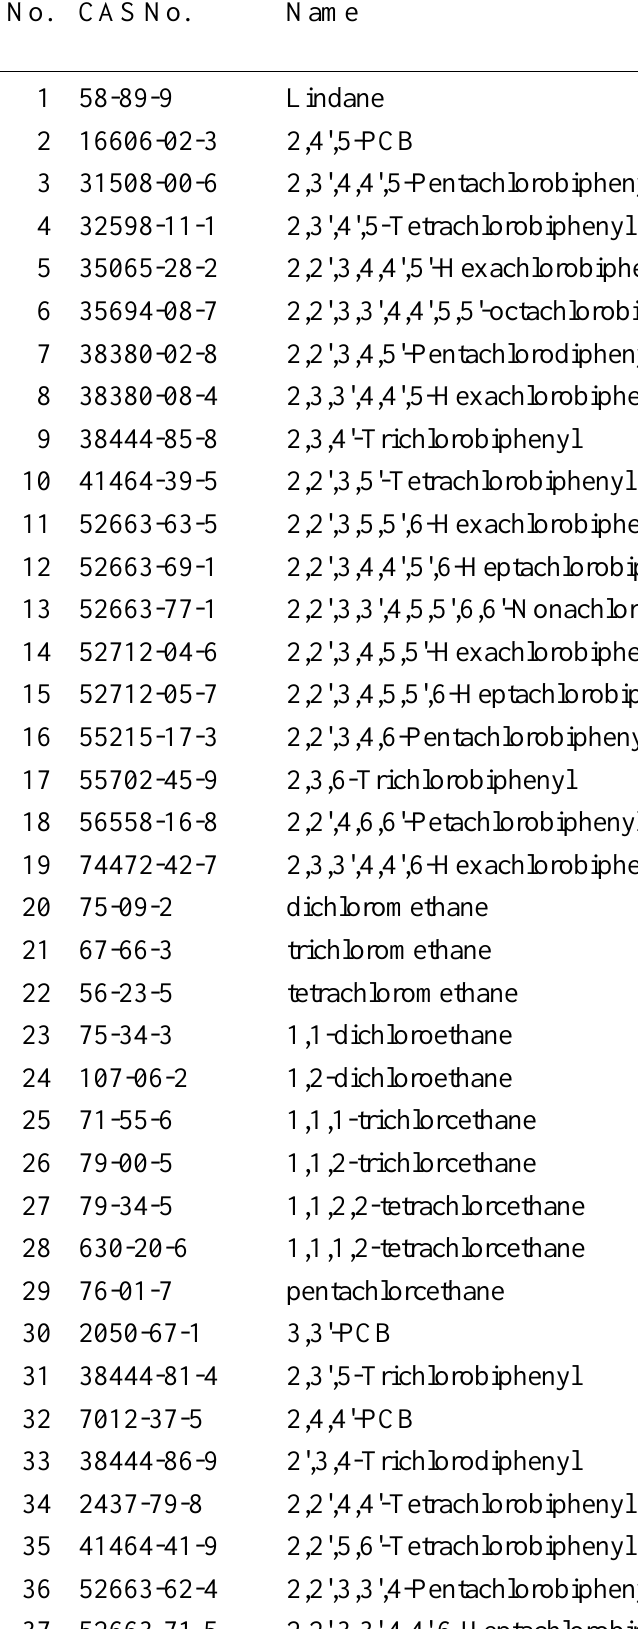
Table 4. Predicted Results of the Molar Aqueous Solubility for 73 compounds (logSw) No. CAS